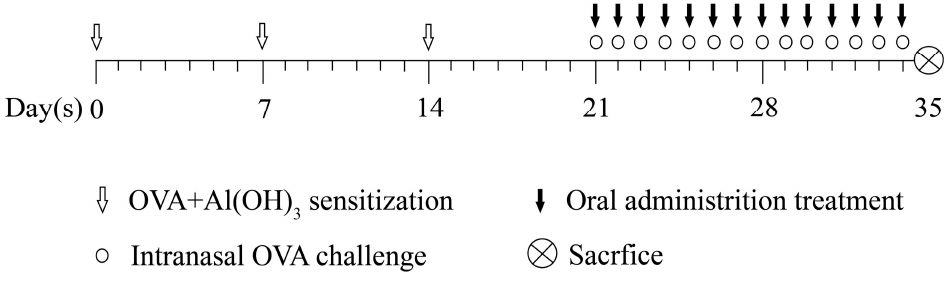
Figure 6. Flow chart of the OVA-induced AR model and ALA administration.